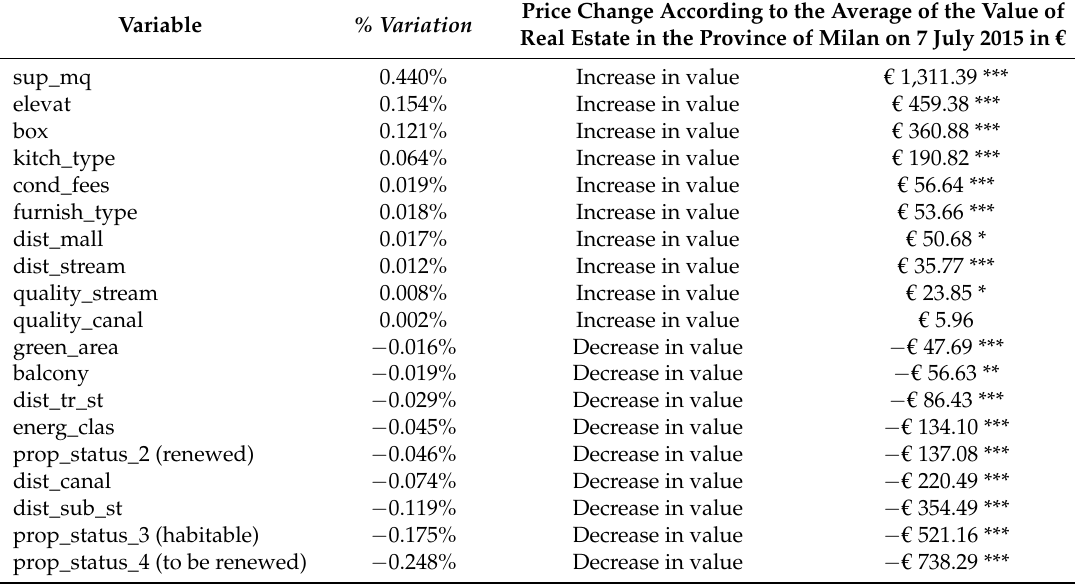
Table 5. Price change according to the average of the value of real estate in the province of Milan. Price Change According to the Average of the Value of Real Estate in the Province of Milan on 7 July 2015 in